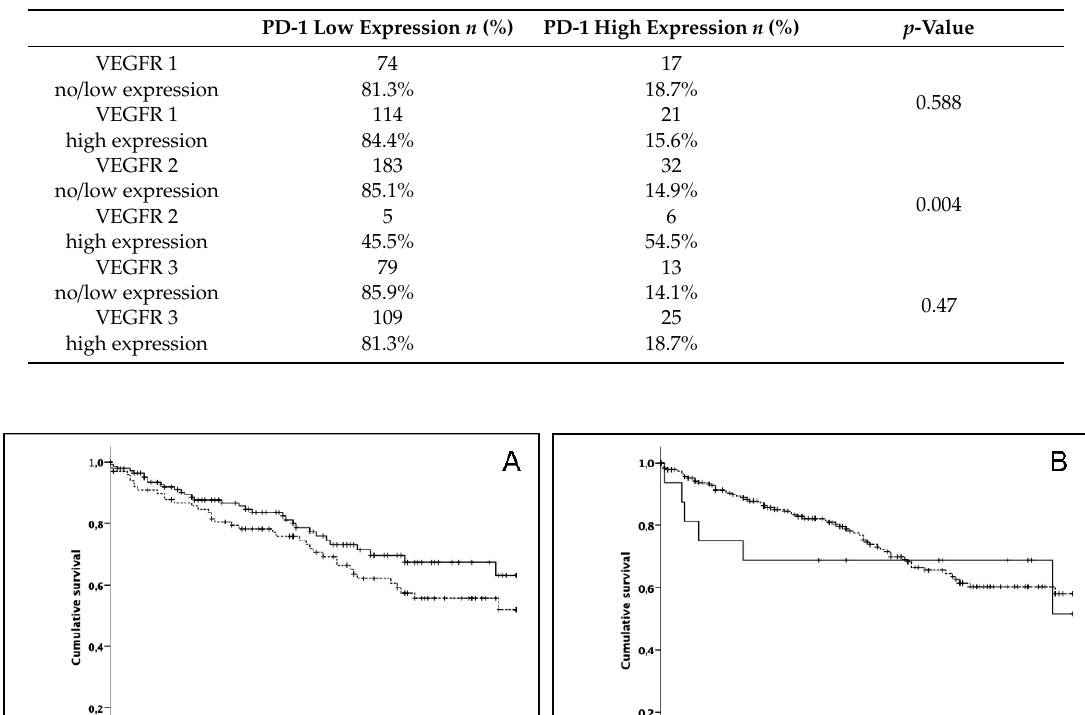
Table 3. Correlation of VEGFR 1-3 and PD-1 (programmed death-1).